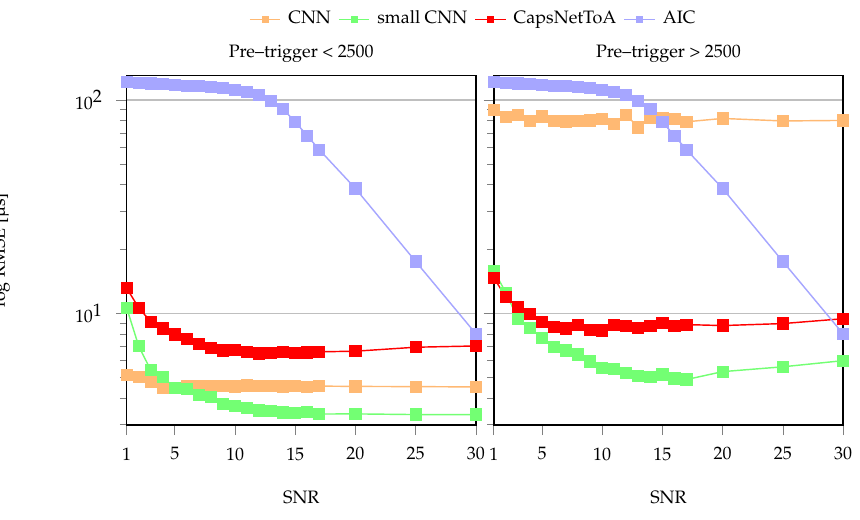
Figure 6. RMSE error for ToA estimation on synthetic test dataset for varying SNRs: Pre–trigger window used for training (i.e., window lower than 2500 samples) on the left and increased pre– trigger window on the